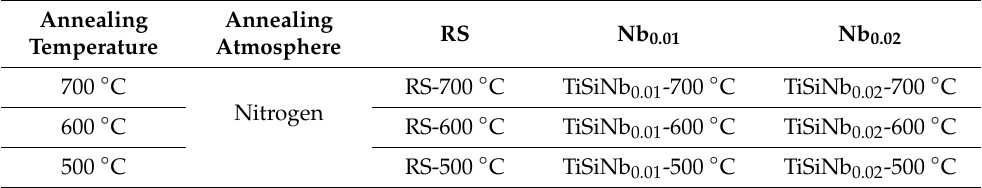
Table 2. Di ff erent annealing conditions and processing of the thin-film solid oxide coating (TFSOC) on the reference sample (RS)